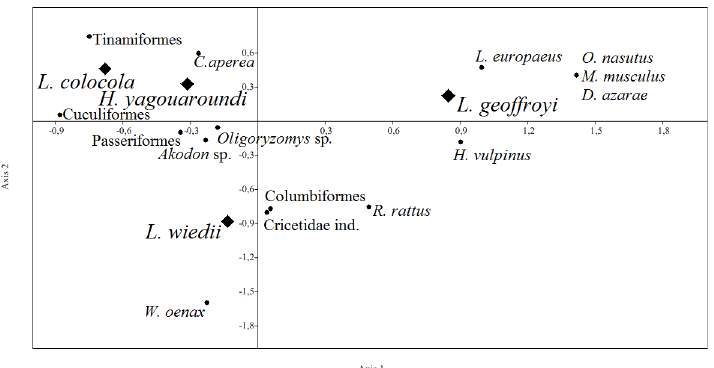
Fig 2. Correspondence analysis of the main food groups (circles) in the diet of four sympatric small cats (diamonds) in the Brazilian Pampa. The first axis accounts for 45.5% of the total variation and the second accounts for